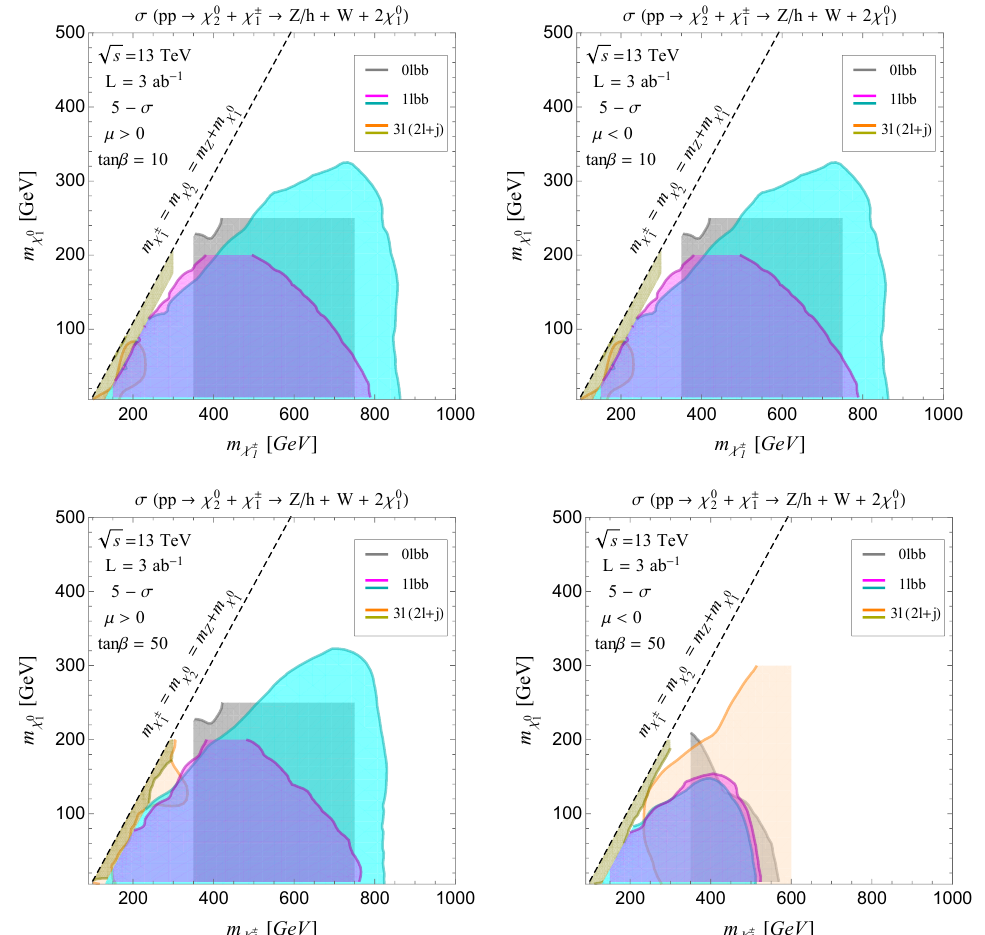
Figure 11 . The future potential on the Bino-Wino scenario projected for 5 σ reach at 3 ab − 1 with M SUSY = | µ | = 10 TeV. The labels are similar to figure